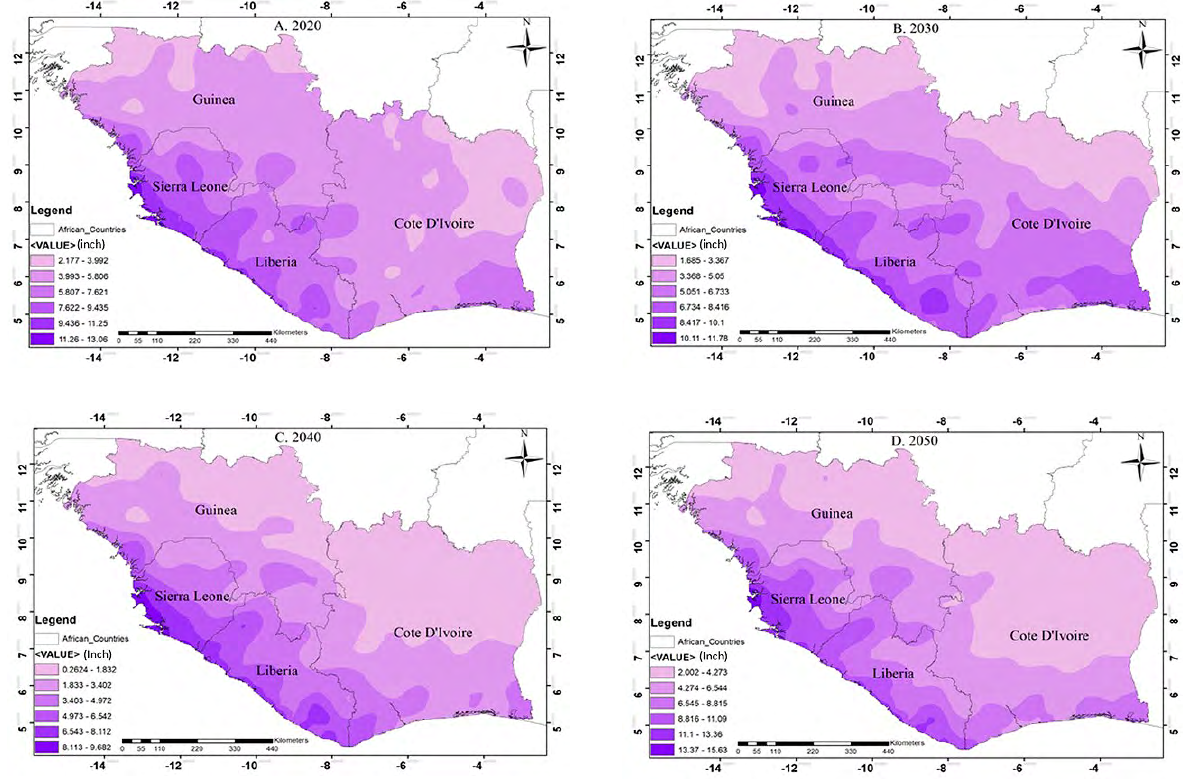
Figure 4. Decadal Spatial Distribution of Precipitation (inch) in the MRU region for the period